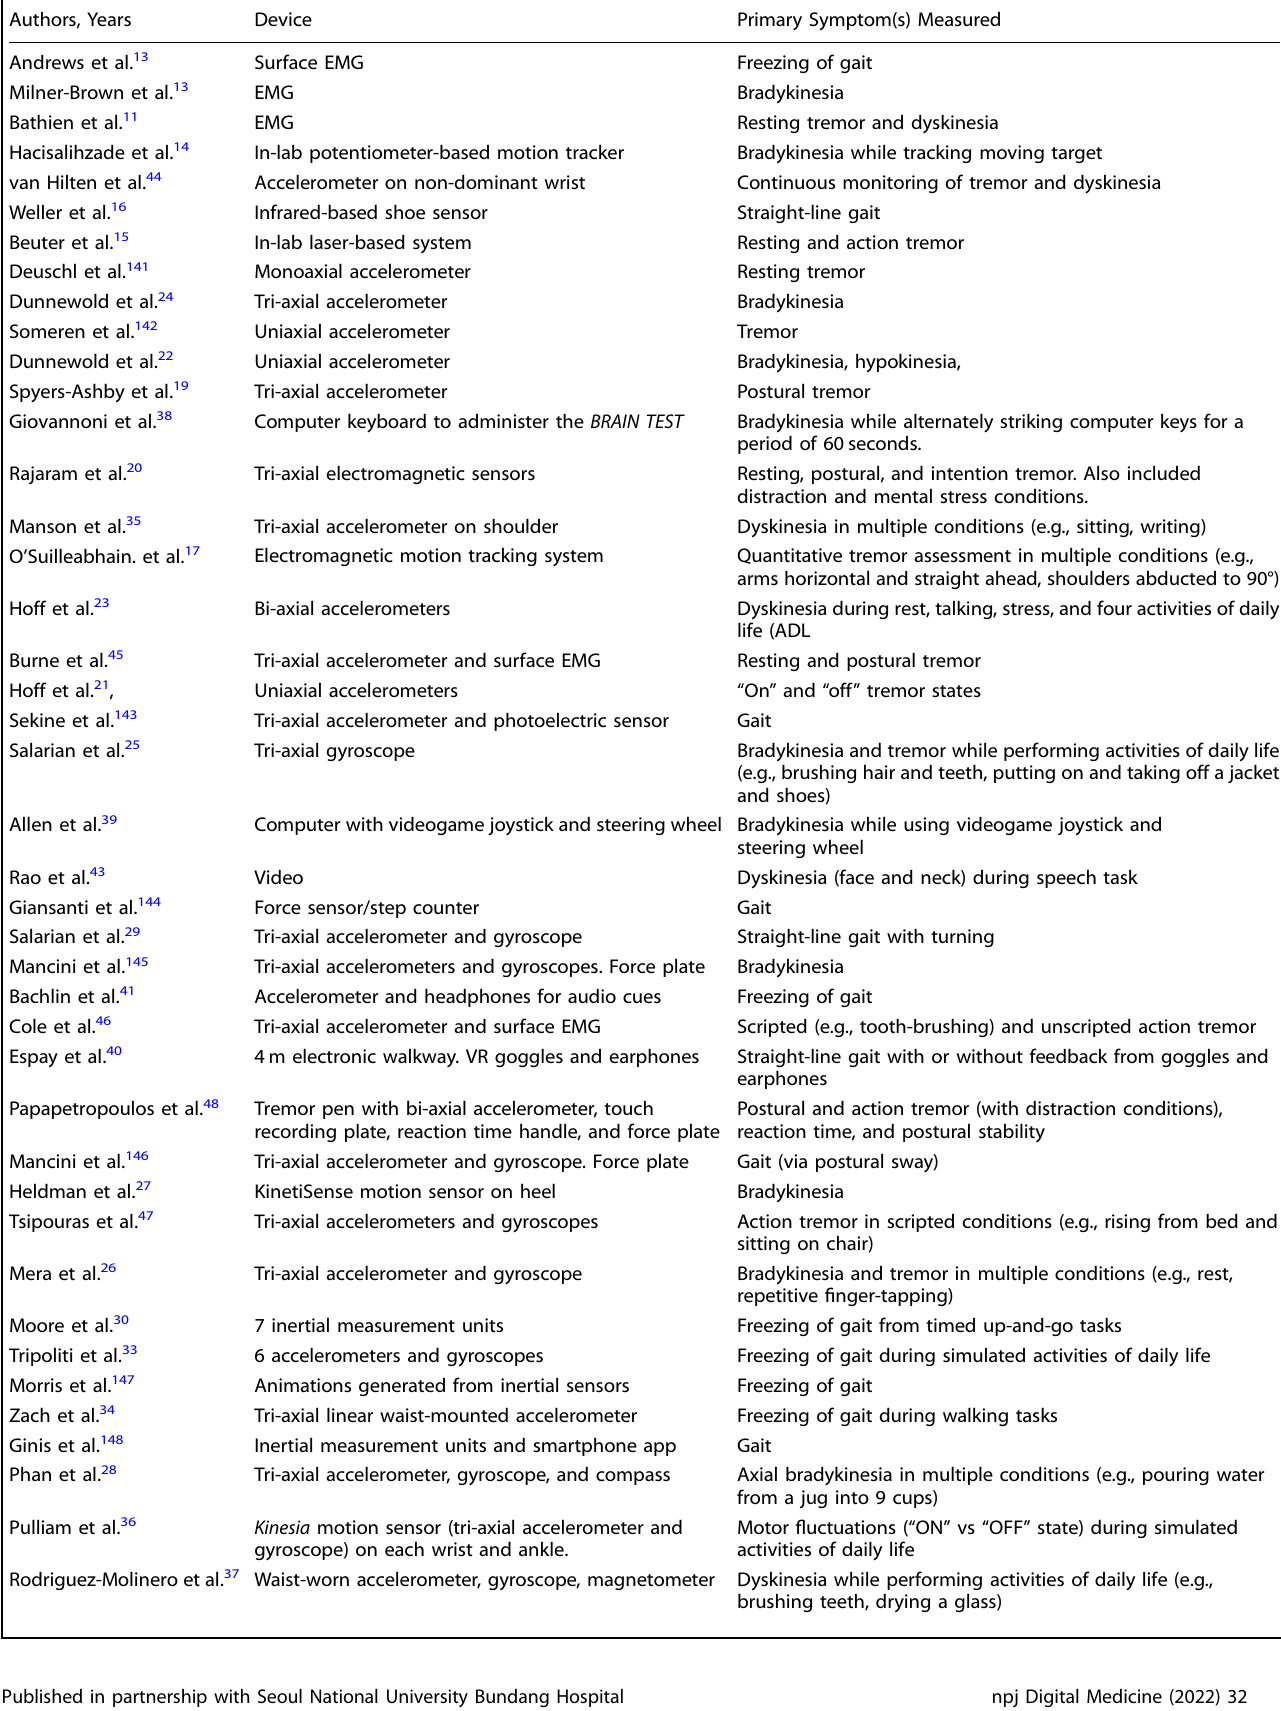
Table 1. Progression of technology used to monitor and assess PD symptoms in laboratory/clinic